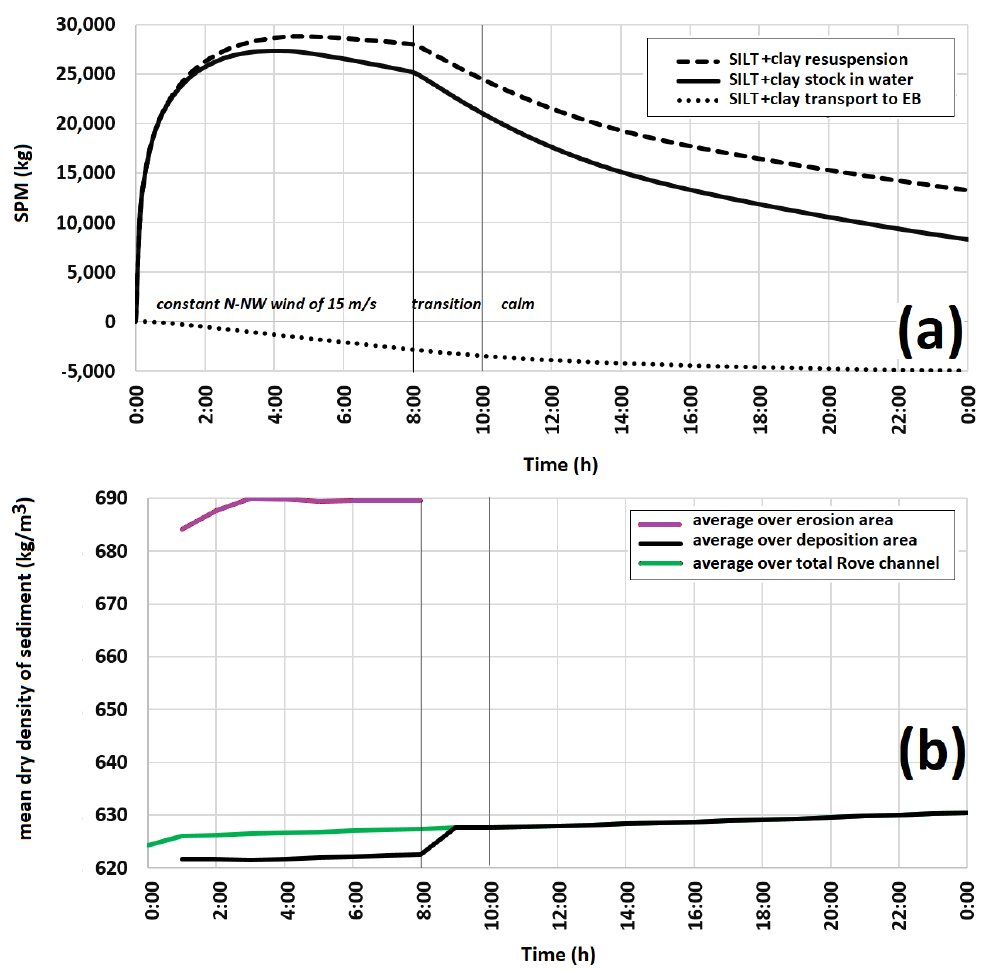
Figure 8. ( a ) Evolution of cumulative fluxes and stocks of suspended particulate matter (kg) and ( b ) evolution of mean dry density (kg/m 3 ) of sediment (over all the Rove Canal); scenario SC N-NW ,15